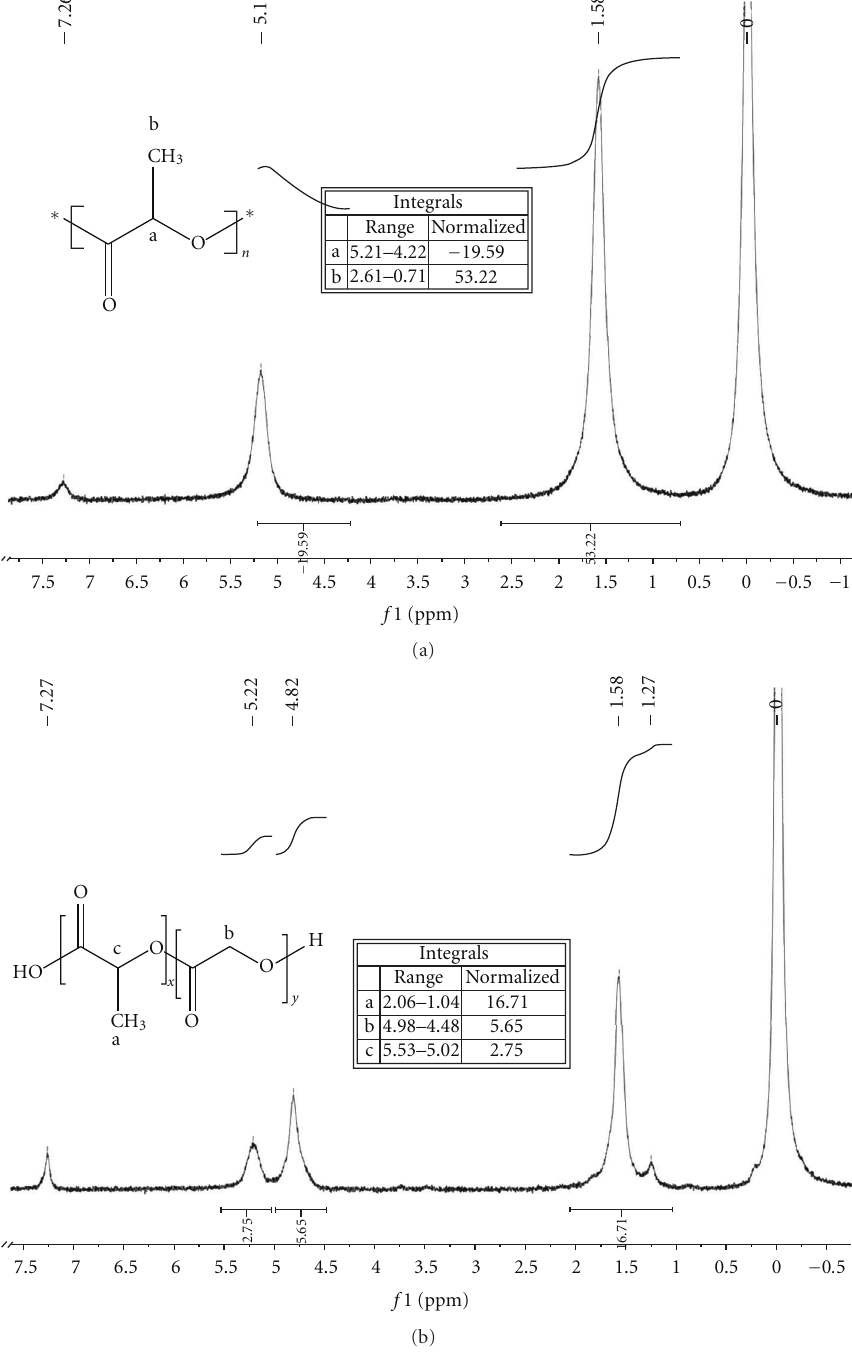
Figure 2: 1 H-NMR spectra of CPL1/130 ◦ C (a) and CPLG (b) blends in CDCl 3